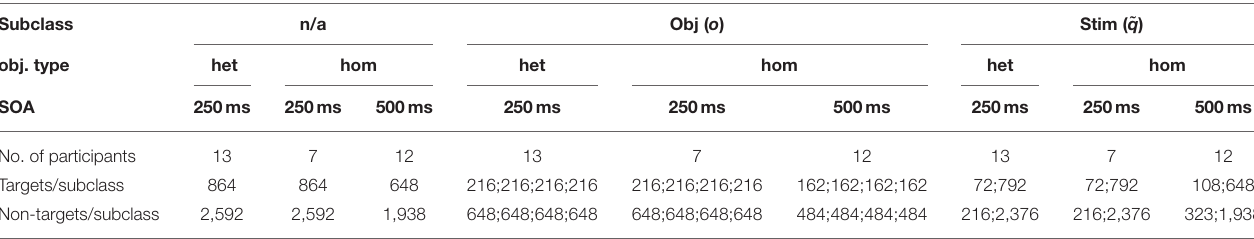
TABLE 1 | Dataset Characteristics: Number of participants and stimuli for the different datasets, grouped by subclass definition. Subclass n/a Obj ( o ) Stim ( ˜ q ) obj.